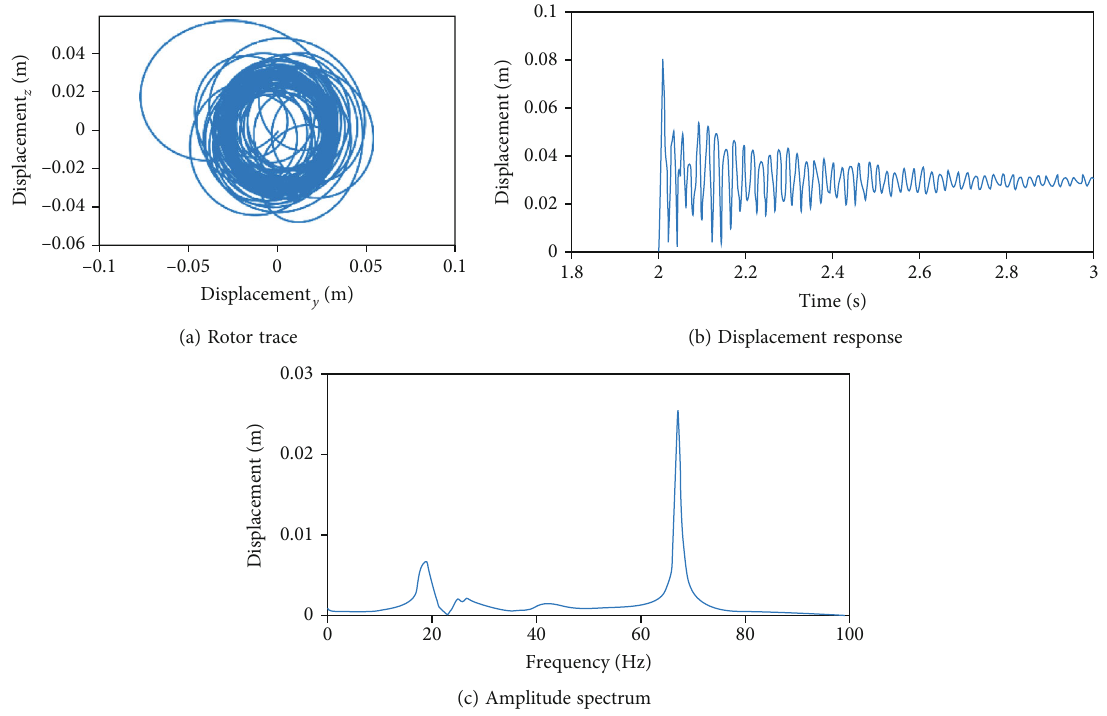
Figure 16: Response of rotor system with a variable-sti ff ness fusing